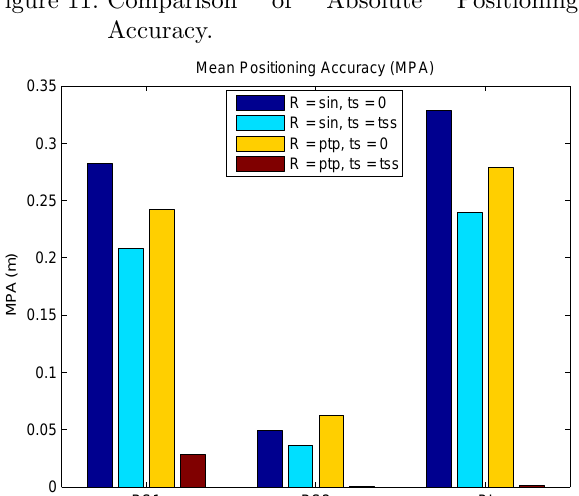
Figure 11: Comparison of Absolute Positioning Accuracy.